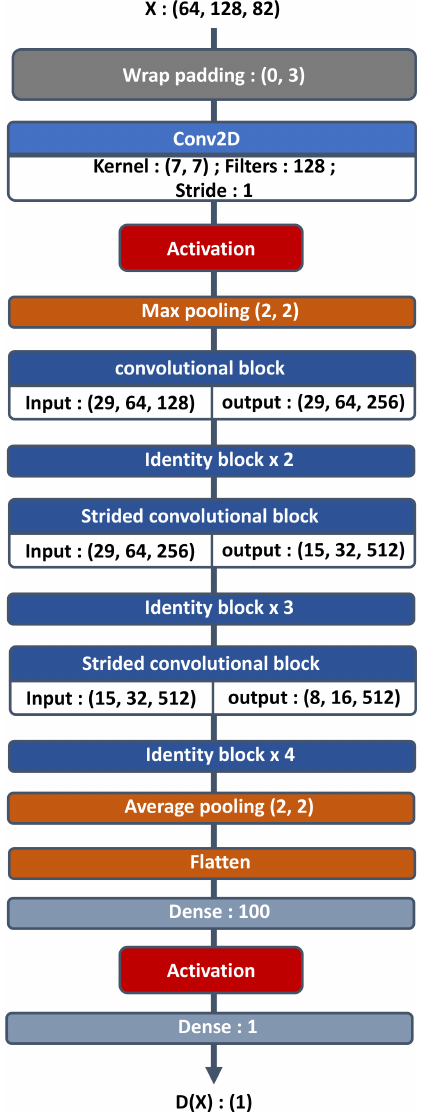
Figure 1. Critic architecture.